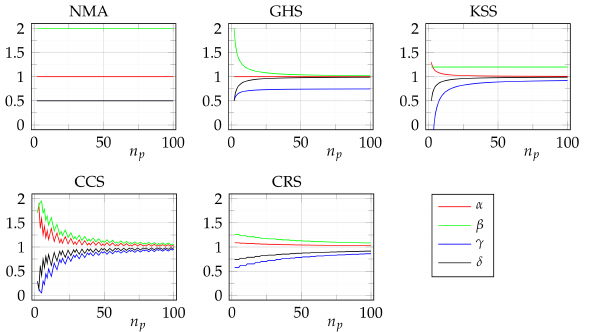
Figure 1. Parameter schema functions for the original Nelder–Mead Algorithm (NMA), Gao–Han Schema (GHS), Kumar–Suri Schema (KSS), Chebyshev Crude Schema (CCS), and Chebyshev Refined Schema